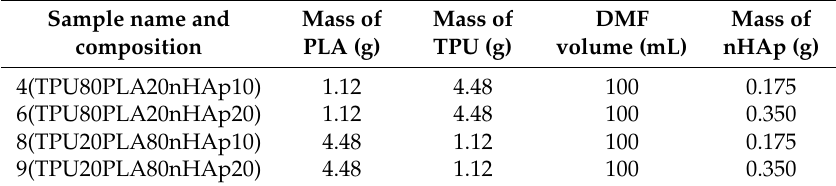
Table 1. Composition of the polymer nanocomposite